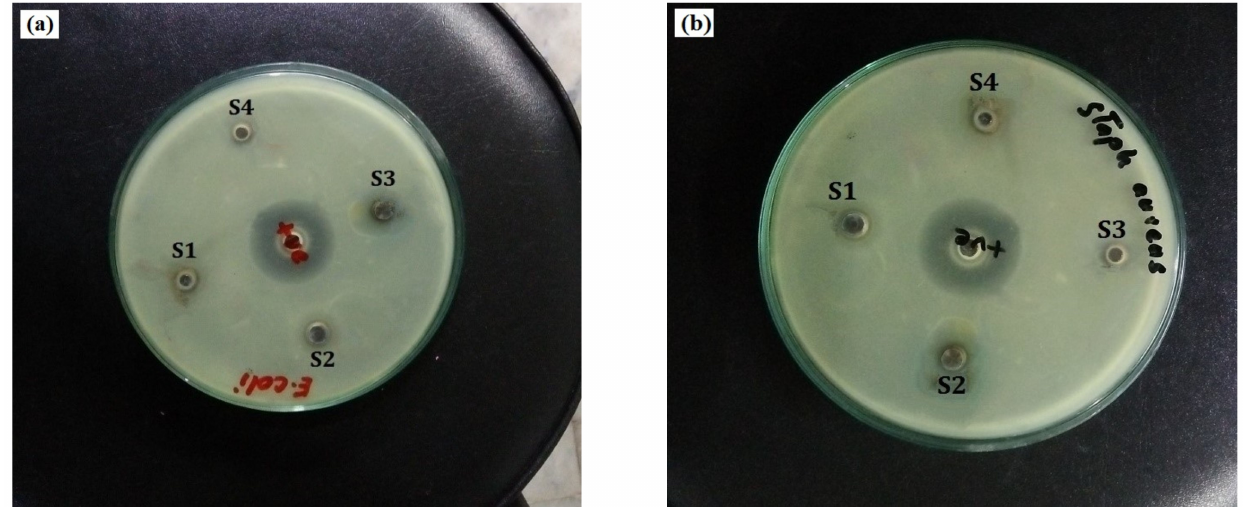
Figure 11. ( a , b ) The images represent the antibacterial activity of optimized AgNPs against Gram +ive and Gram − ive bacterial